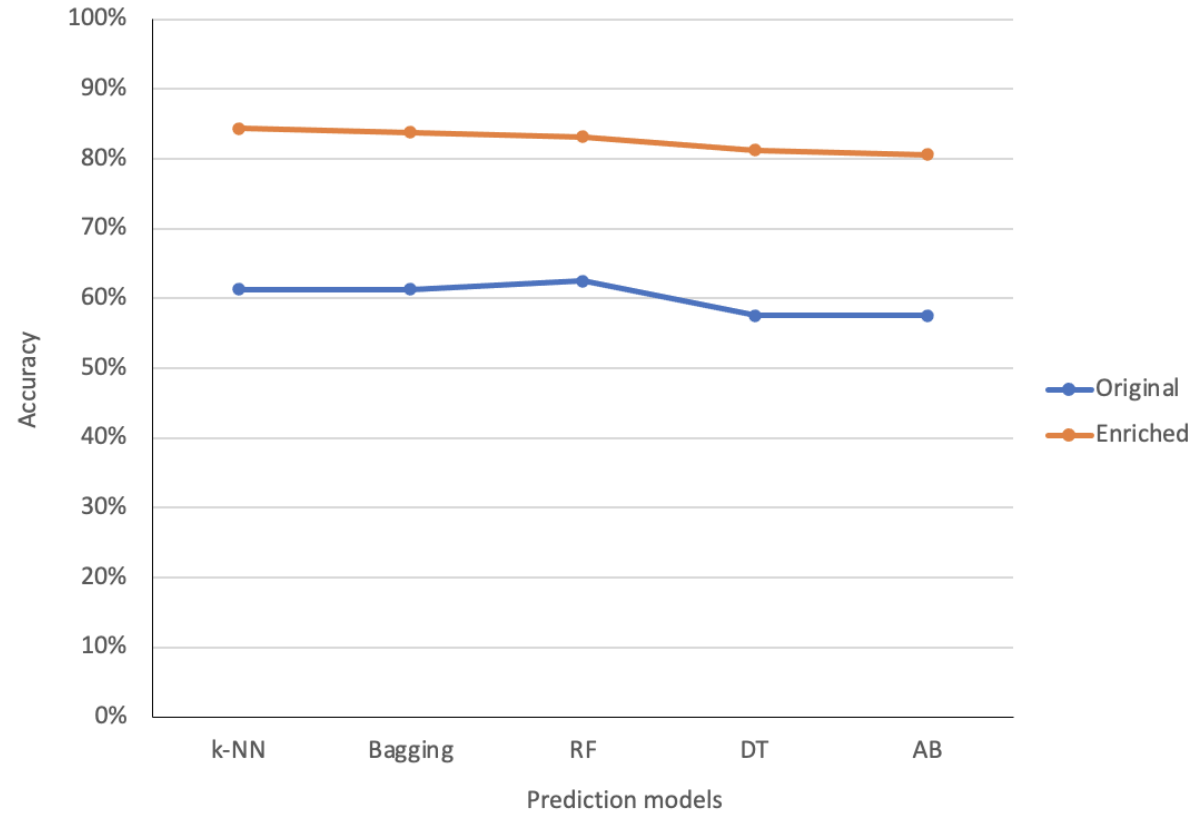
Figure 1. Comparison of the accuracy between models before and after data enrichment. AB: AdaBoost; DT: decision tree; k-NN: k-nearest neighbor; RF: random